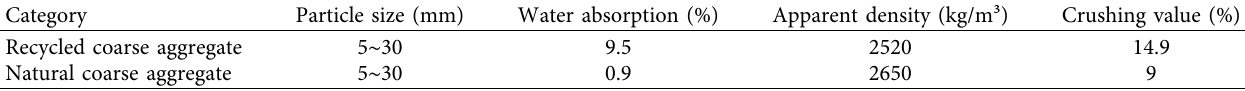
Table 1: Physical properties of coarse aggregate.